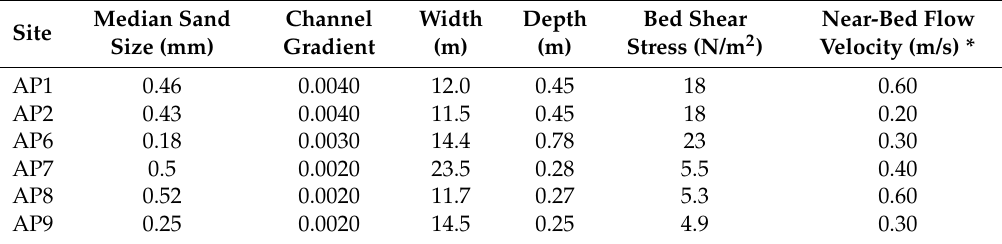
Table 2. River parameters measured at the sampling sites on the Apies River.